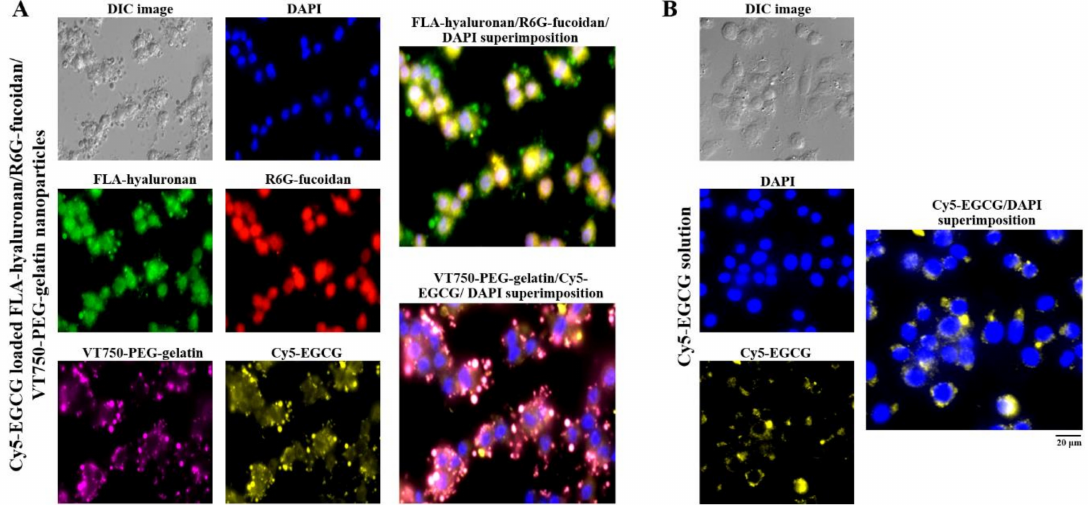
Figure 5. The intakes and distributions were observed and quantified using fluorescence microscopy. ( A ) Fluorescence nanoparticles composed of fluoresceinamine (FLA)-hyaluronan, R6G-fucoidan, VT750-PEG–gelatin, and Cy5-EGCG were given to macrophages and ( B ) Cy5-EGCG solution was given to macrophages. The cell nuclei were stained with 4 (cid:48) ,6-diamidino-2-phenylindole (DAPI). Scale bar: 20 µ